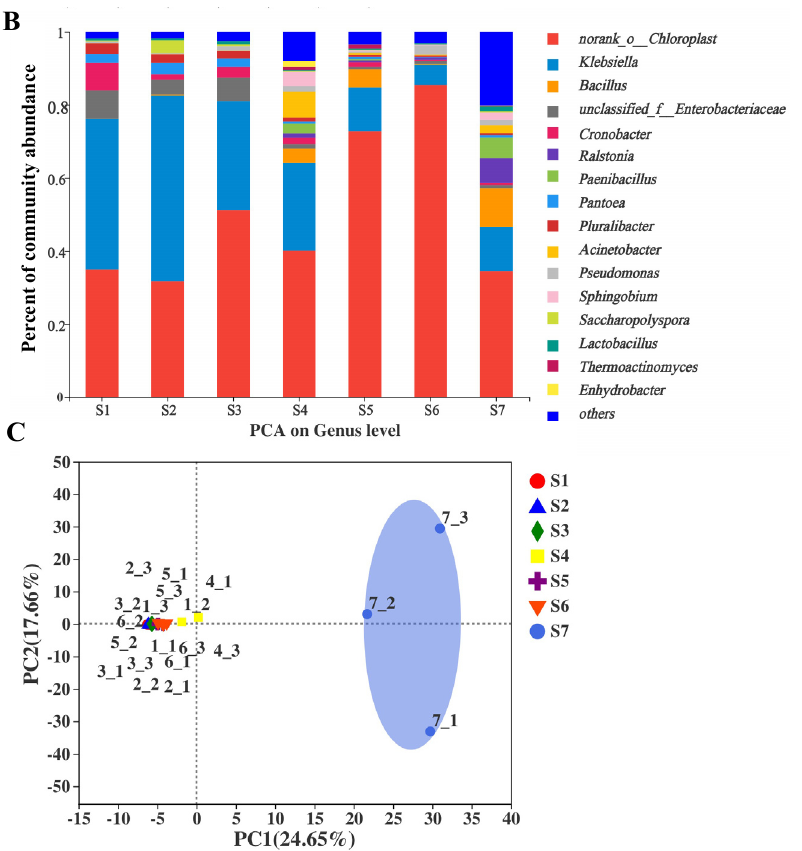
Figure 2. Comparisons of bacterial composition and richness in different samples of Fu brick tea. ( A ) Venn diagram analysis of bacterial OTU level in samples during manufacturing process Fu brick tea. ( B ) Bacterial taxonomic compositions showing the bacterial successions at species level. The bacterial communities in eight period samples are comparable diverse. ( C ) Principal component analysis (PCA) of bacterial communities in 7 FBT samples at the species level. (note: The taxonomic abundance < 1% were classified into “others”.)